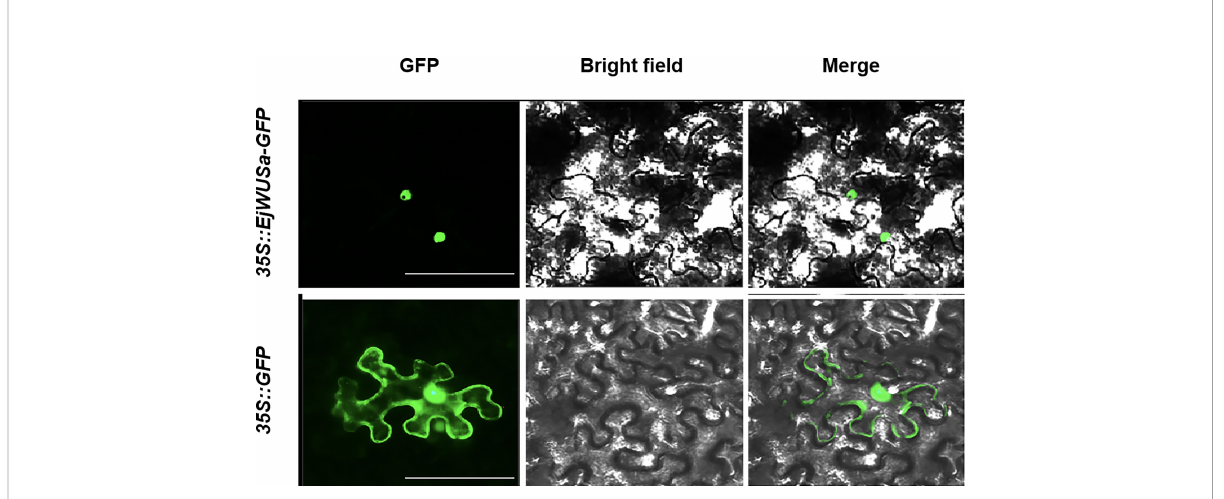
FIGURE 6 Subcellular localization of EjWUSa in tobacco leaves. GFP, GFP fl uorescence channel; Merged, merged image of GFP and bright fi eld. Bars = 50